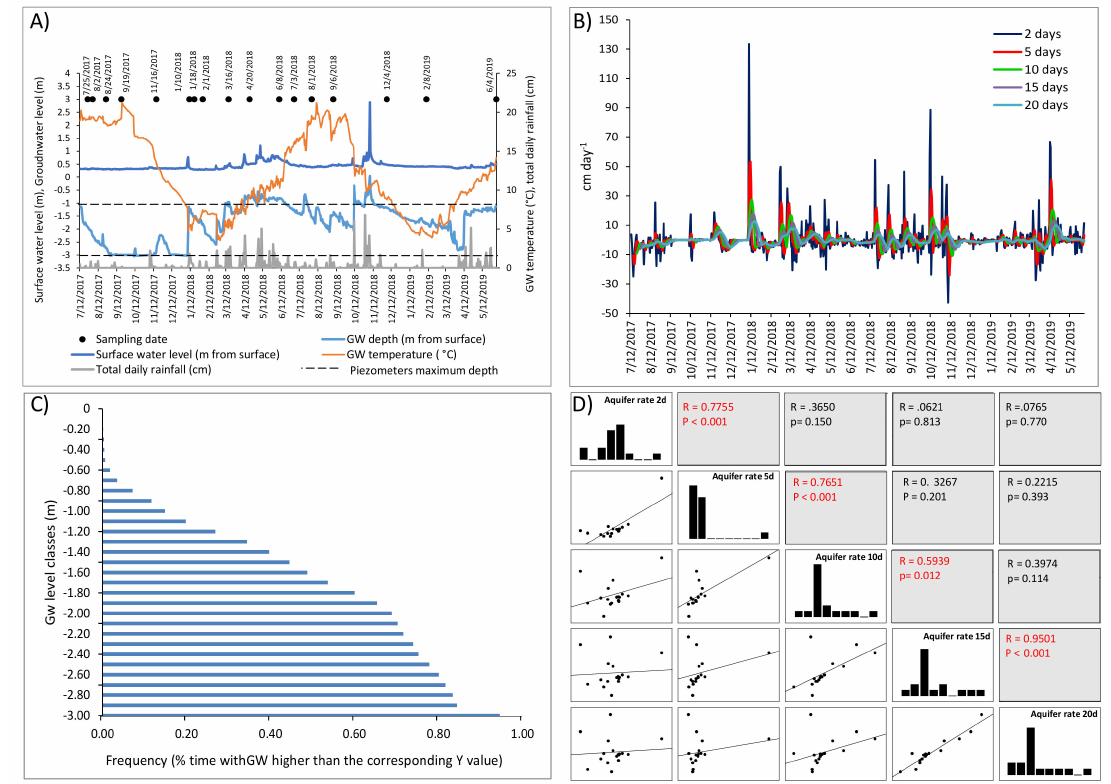
Figure 1. ( A ) Groundwater depth and temperature (deep intermittent site); surface water level (Villafranca monitoring station); total rainfall (Saluzzo monitoring station). ( B ) Time series of aquifer recession rates calculated over 2, 5, 10, 15, 20 days intervals; positive rates: aquifer level rising, negative values: aquifer level falling. ( C ) Groundwater permanence (fraction of monitoring days during which the groundwater table was recorded above a given depth). ( D ) Correlations between aquifer oscillation rates calculated over di ff erent time intervals (2, 5, 10, 15, 20 days); significant correlations written in